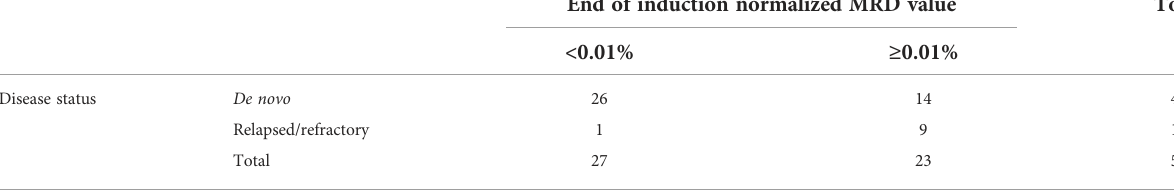
TABLE 2 Correlation between patient disease status and end of induction minimal residual disease value using a threshold value of 0.01.